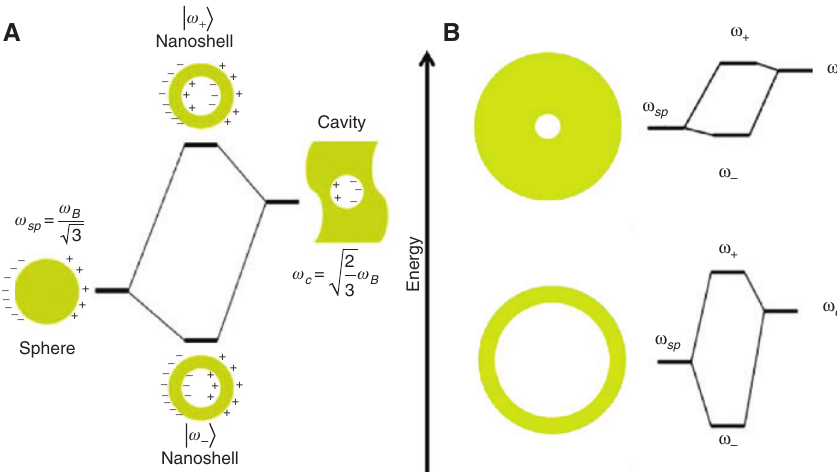
Figure 1: Plasmon hybridization mechanism. (A) Schematic energy-level diagram illustrating the plasmon hybridization mechanism in metal nanoshells as a result of the interaction between the sphere ( ω ) and cavity ( ω ) plasmons. Anti-symmetrically coupled, anti-bonding, mode sp c ( ω ) and symmetrically coupled, bonding, mode ( ω ) are shown (reproduced with permission from Ref. [13], copyright 2003 American Associa- + − tion for the Advancement of Science). (B) Extent of the hybridization for thick (upper) and thin (lower) metallic shells revealing that the hybridi- zation is much more significant for the thin metallic shell (adapted with permission from Ref. [39], copyright 2011 Cambridge University